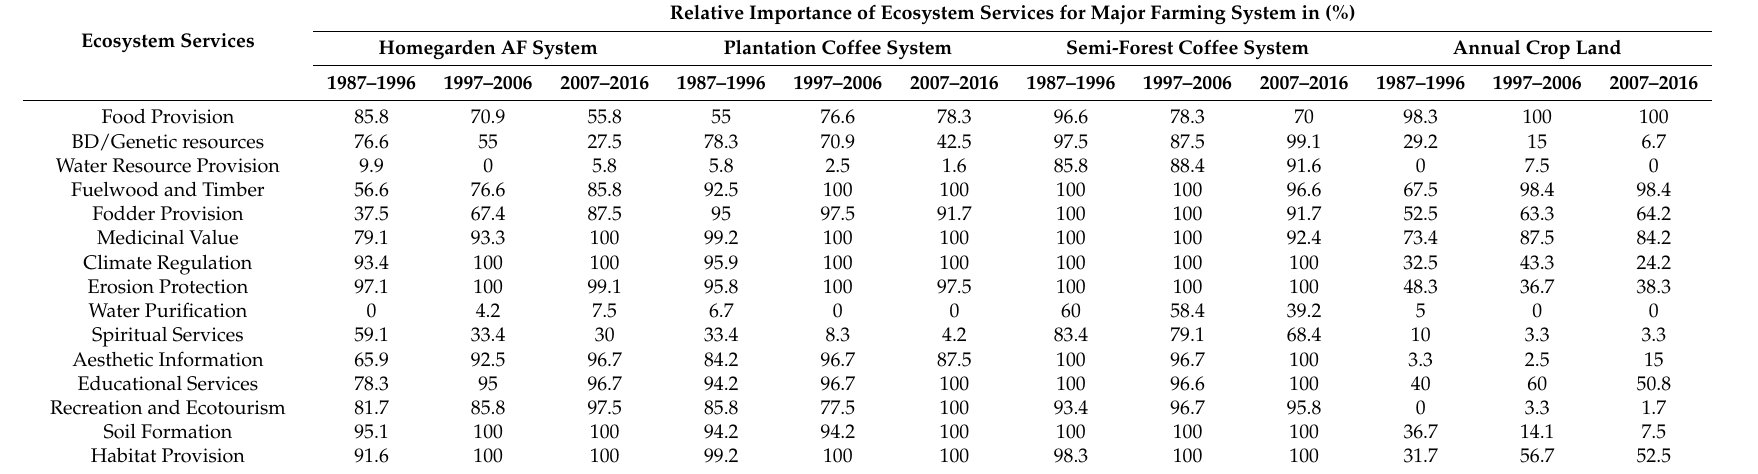
Table 3. Dynamics and temporal trends of ecosystem services of the major farming systems in the Yayo